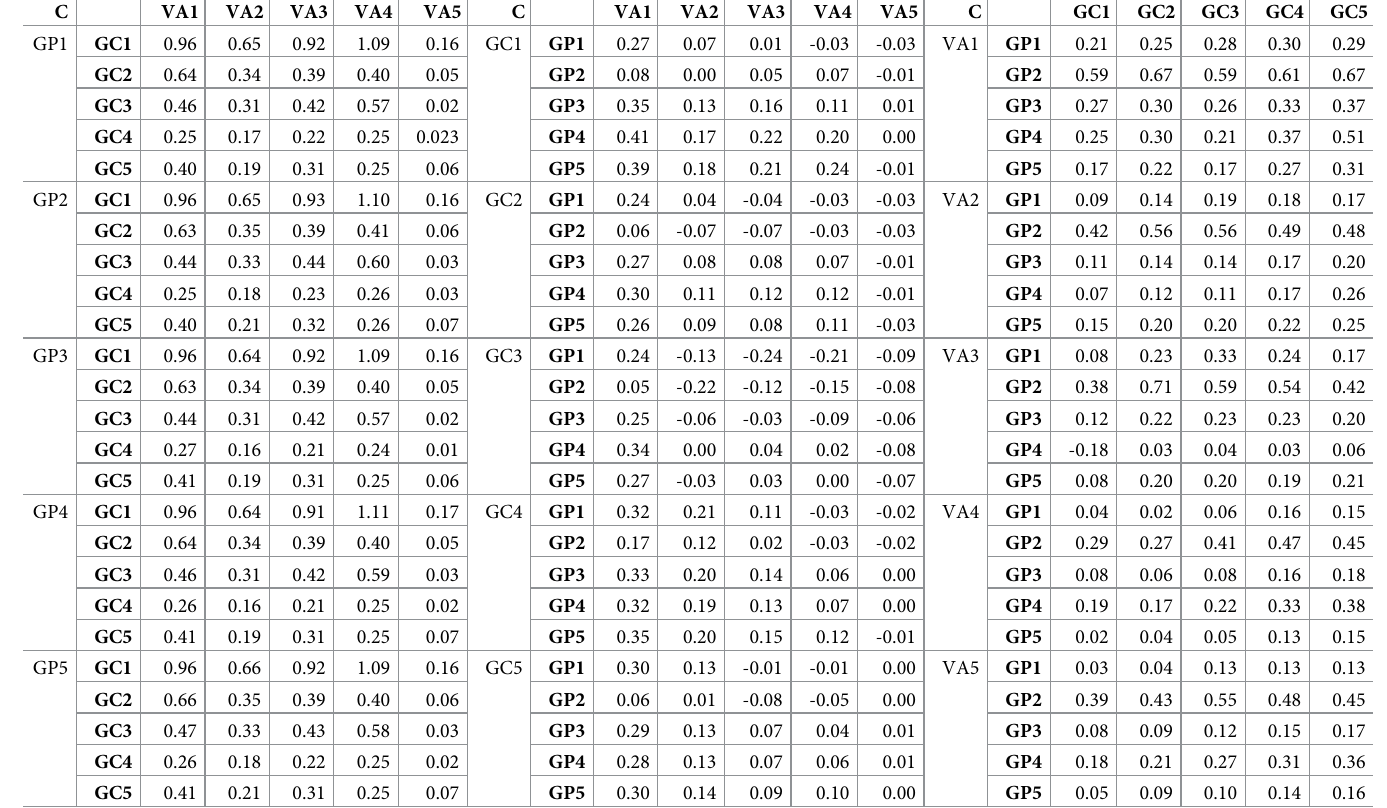
Table 2. Estimates for the β coefficients, which represent the contemporaneous causal relationships between the study variables, for different search term combina- tions. The C variables represent the variables included in the model but not part of the corresponding pairwise relationship. Cell values represent the β coefficients for con- temporaneous pairwise (causal) relationships between the variables in bold from the corresponding columns (causes) and rows (effects). C